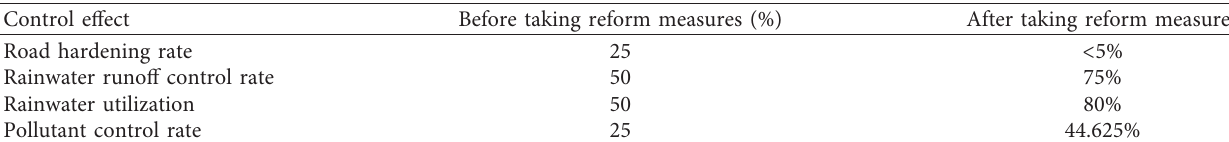
Table 7: Comparative analysis table before and after low-impact development and transformation measures.